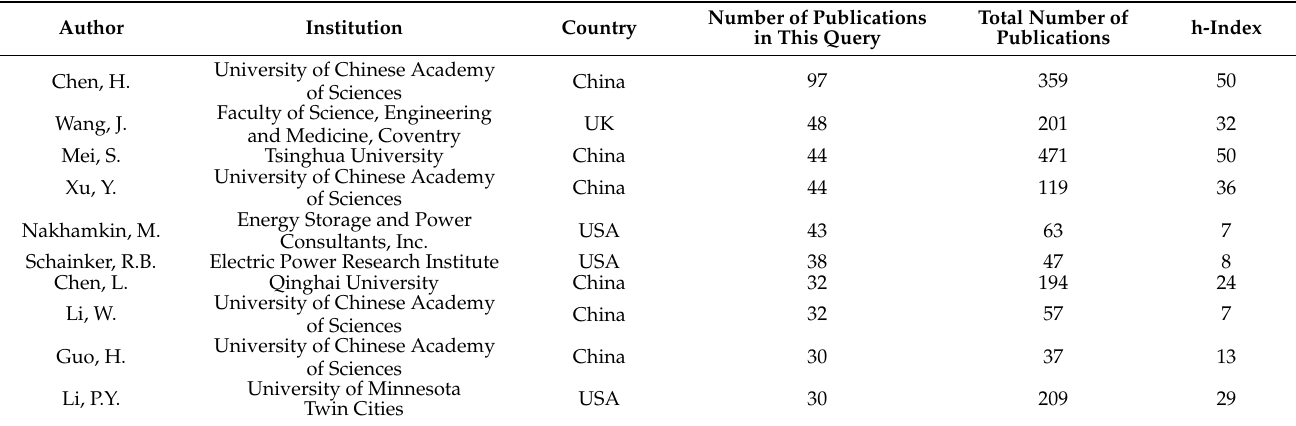
Table 3. Top list of authors publishing on CAES.